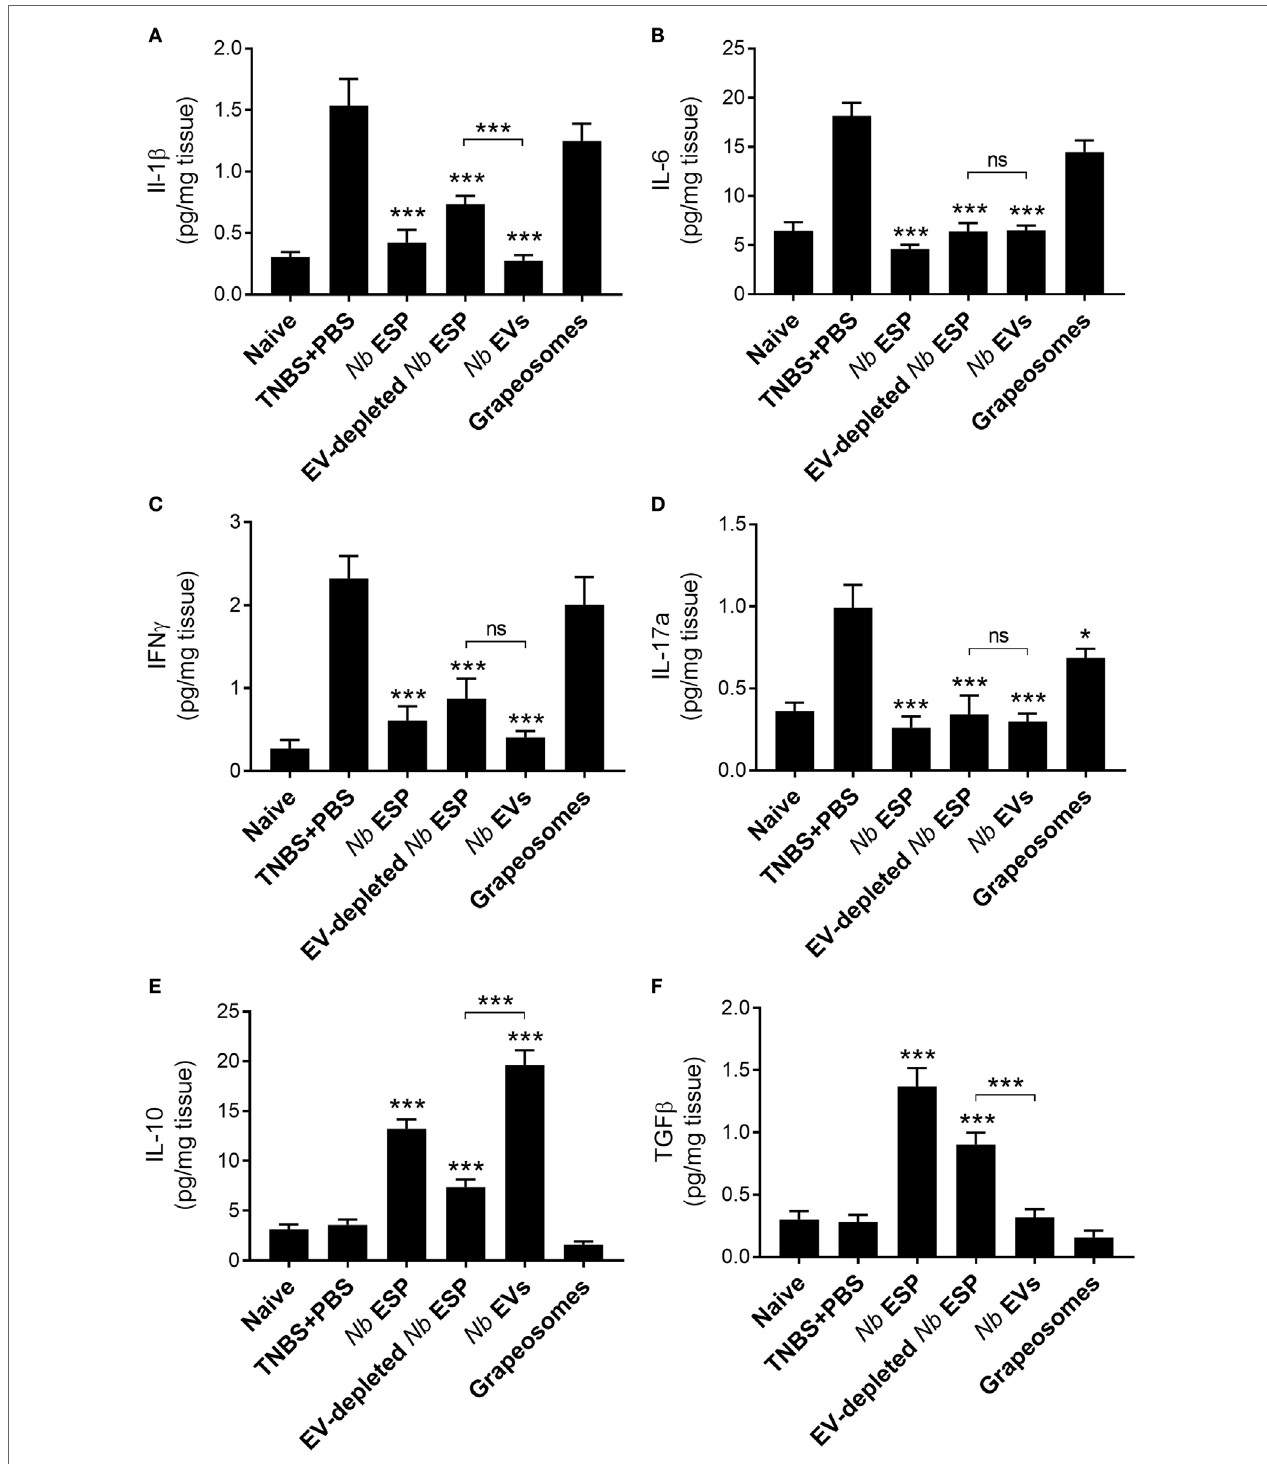
FigUre 5 | Nippostrongylus brasiliensis extracellular vesicles (EVs) suppress colonic inflammatory cytokine production and promote IL-10 secretion in mice. Cytokine profile of cultured colon tissue of healthy naïve mice, mice treated with N. brasiliensis secreted products, PBS colitis control and grape-vesicle (grapeosomes) control mice. (a) IL-1 β ; (B) IL-6; (c) IFN γ ; (D) IL-17a; (e) ; IL-10; and (F) TGF β . All groups were compared to the PBS + TNBS (colitis) control group; the N. brasiliensis secreted protein group (EV-depleted) was also compared with the purified vesicles group (bracket). All comparisons were performed using a Mann–Whitney U -test. * p < 0.05; ** p < 0.01; *** p < 0.001. Error bars represent mean ±